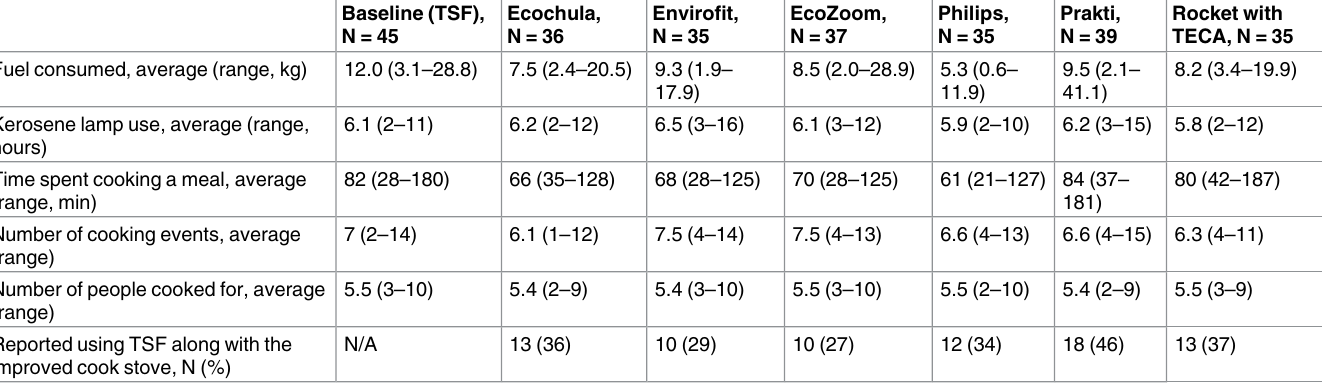
Table 2. Stove use, cooking practices, and fuel consumption during the 48-hour monitoring period by stove